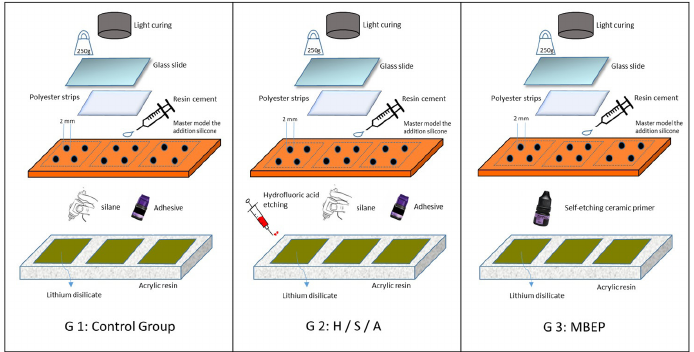
Figure 2. Sequence of sample preparation for shear test (G1: NT samples; G2: HF samples; G3:SECP).